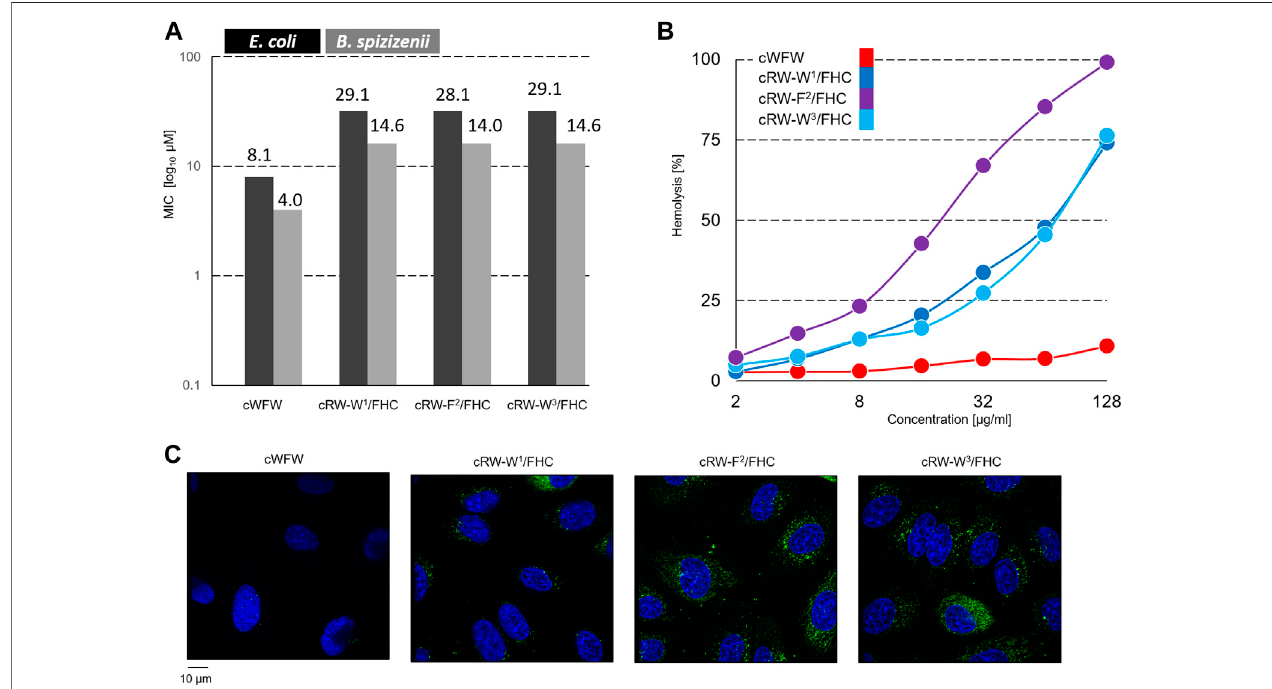
FIGURE 3 | (A) Planktonic bacterial growth inhibition according to a broth microdilution assay. Numbers depict µM values calculated from µg/ml dilutions; (B) concentration-dependent hemoglobin release from human erythrocyte suspension; and (C) fl uorescence microscopy observation of Hoechst 33342 (blue color)-co- stained Hela cells after 1 h of incubation with 30 µM FHC-labelled cWFW analogues (green color). Images are 105 × 114 µm.